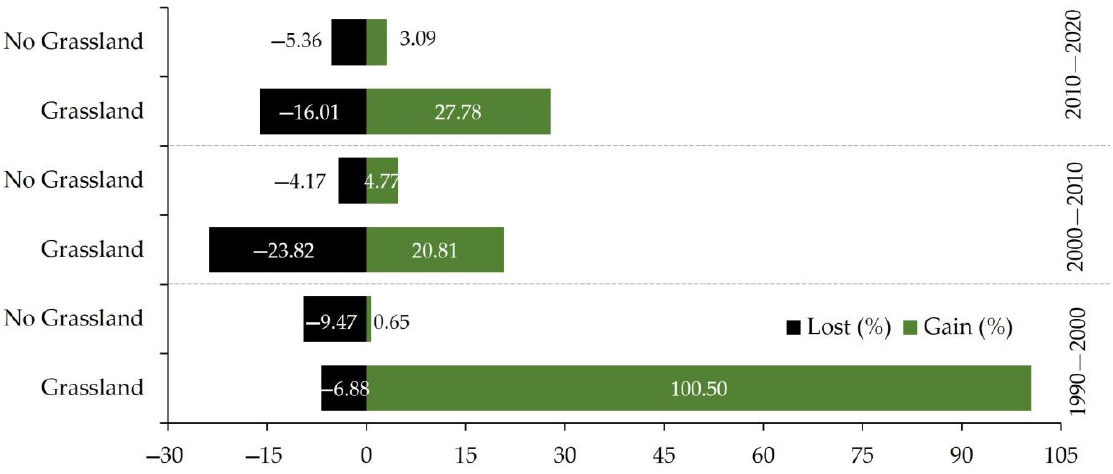
Figure 9. Gains and losses in hectares of grassland and no-grassland for each of the periods of analysis in the Ventilla micro-watershed.